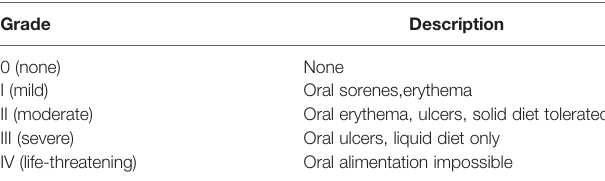
TABLE 1 | The WHO oral mucositis grading scale